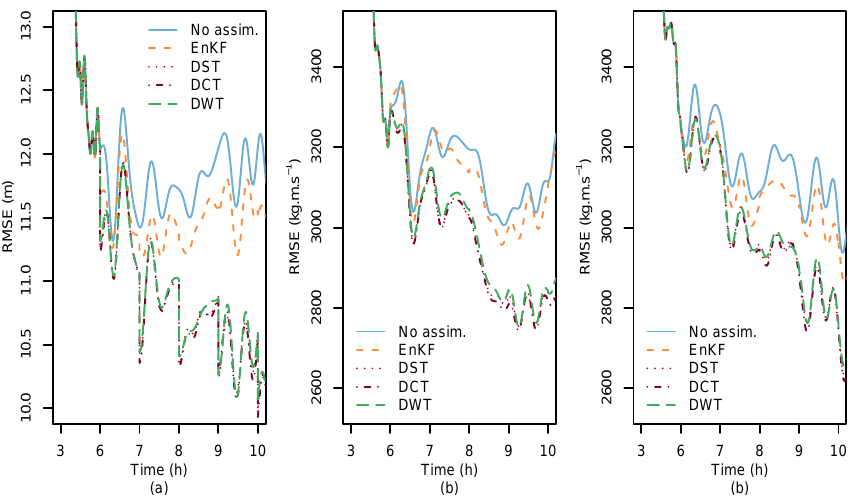
Figure 5. Mean RMSE of ensemble mean from five independent repetitions. Ensemble size 20, only water height observed. (a) Water height, (b) velocity in the x direction and (c) velocity in the y direction.